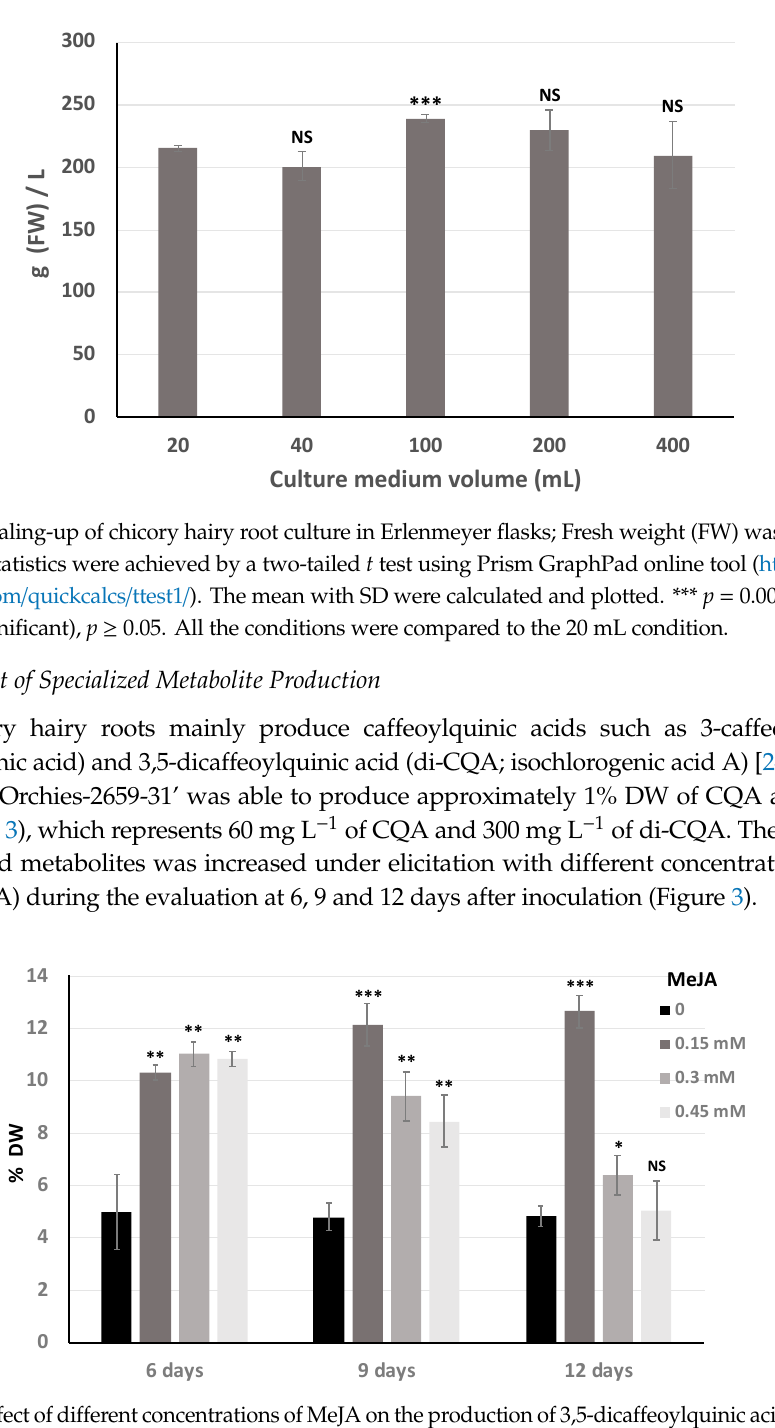
. Figure 4. Stacked HPLC chromatograms of methanolic extracts obtained from hairy root elicitated (pink line) and not elicitated (dark line). ( 1 ) caffeoylquinic acid (5-CQA); ( 2 ) 3,5-dicaffeoyquinic acid (di-CQA); ( 3 ) 3,4,5-tricaffeoylquinic acid (tri-CQA). 2.3. Tri-Caffeoylquinic Acid Production in Chicory Hairy Roots The production of tri-caffeoylquinic acid was evaluated as a function of the MeJA concentration and the elicitation time (6, 9, and 12 days), then the relative absorbance of the peaks was analyzed. The tri-CQA content of hairy roots increased with the duration of elicitation and with the concentration of MeJA (Figure 5).